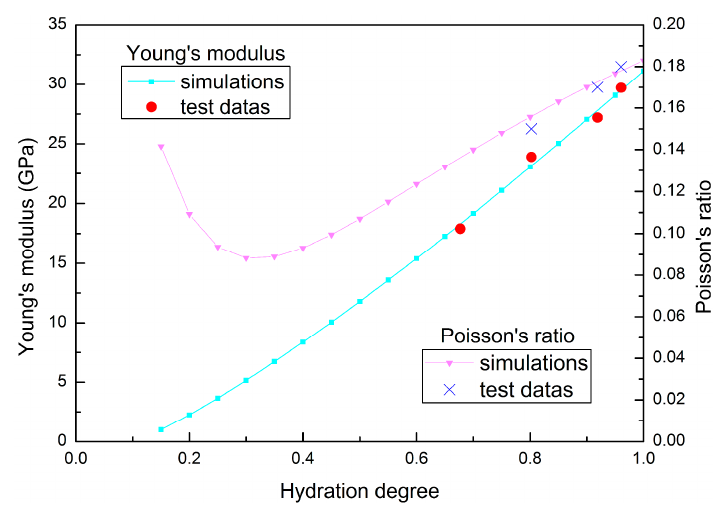
Figure 3. Young’s modulus and Poisson’s ratio evolution for isothermal test of fly ash concrete (w/b = 0.45).